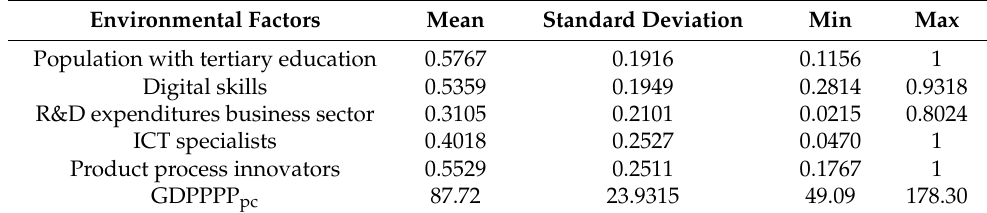
Table 5. Descriptive statistics of the environmental factors.